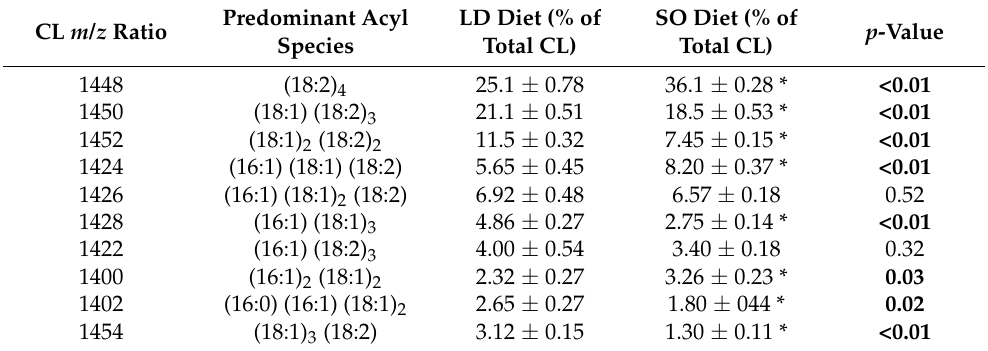
Table 1. Predominant CL species in murine brown adipose tissue mitochondria after 14–18-week consumption of LD and SO